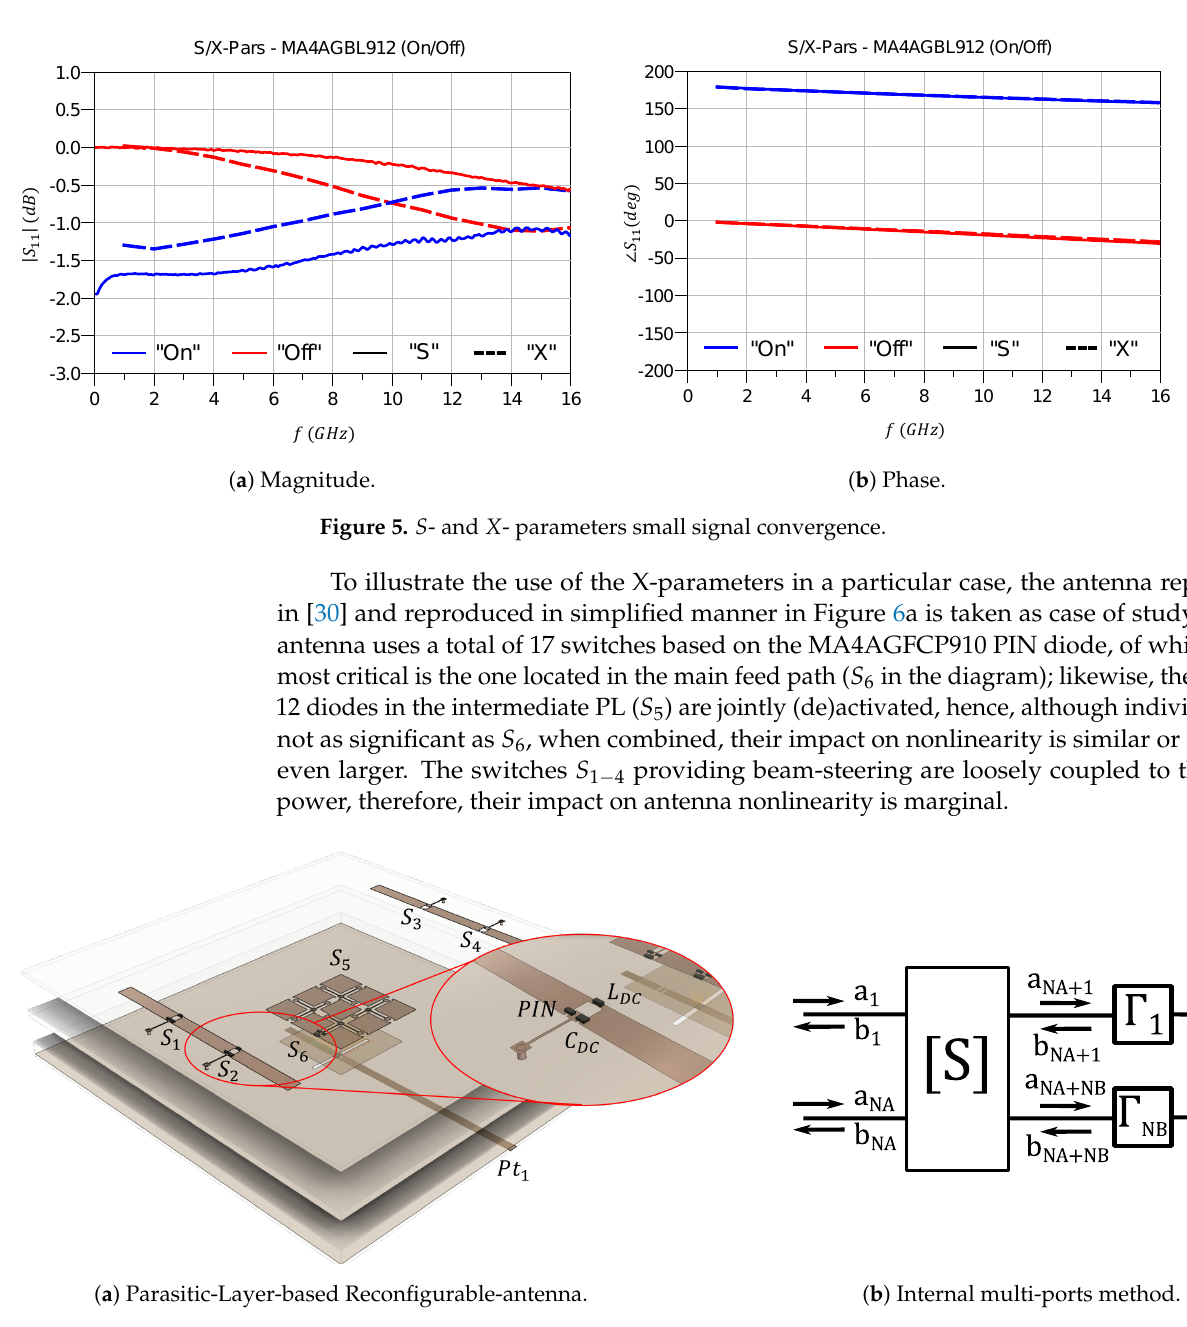
Figure 6. Parasitic-Layer-based Reconfigurable-antenna and antenna equivalent circuit. Notwithstanding that this antenna has 6 diverse modes of operation allowing for beam-steering and bandwidth reconfigurability, given the antenna symmetries and the expected small contribution to nonlinearity of the switches on the upper PL, only modes M 1 , M 4 providing bandwidth reconfigurability are considered for analysis. Switch states for these modes are summarized in Table 1. Table 1. Switch states for the antenna modes of